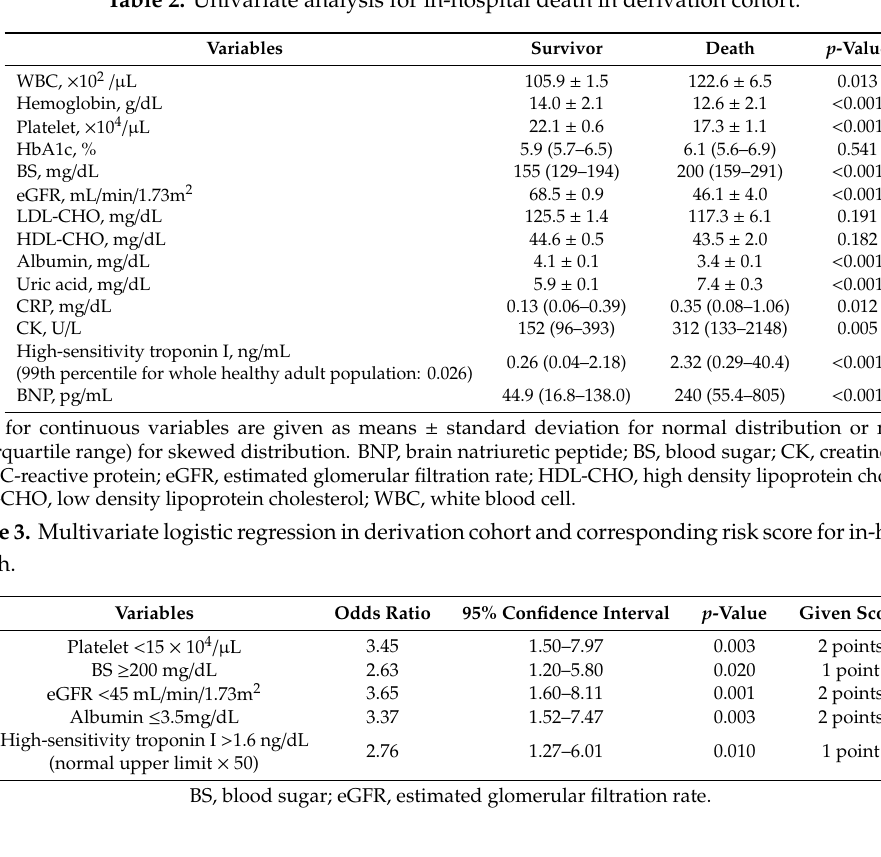
Table 2. Univariate analysis for in-hospital death in derivation cohort.